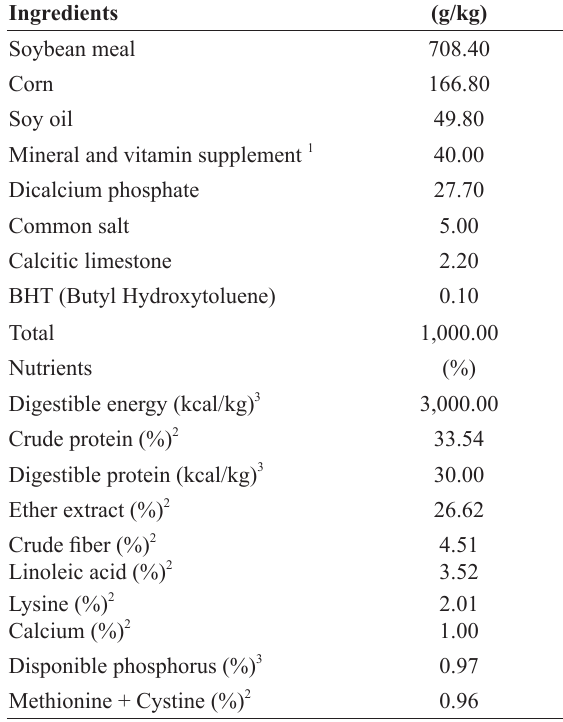
Chemical composition of the diet experimental (natural matter) of Nile tilapia